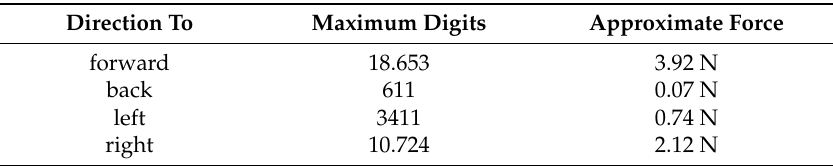
Table 2. Patient measurements and applied force.